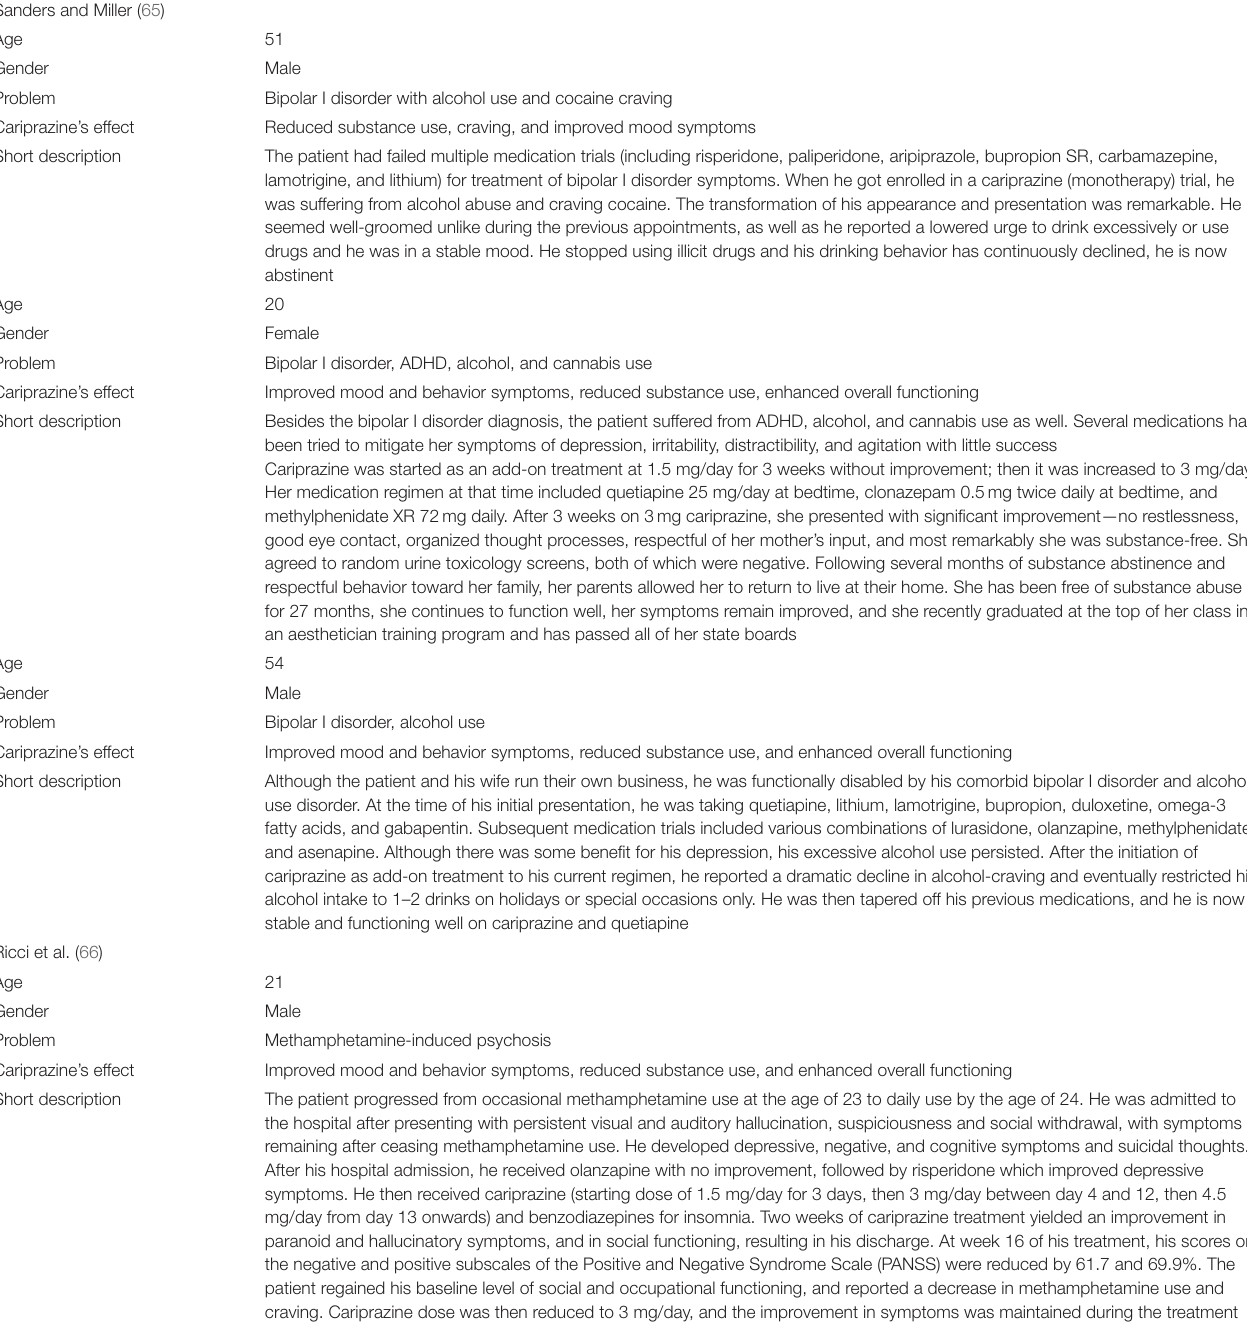
TABLE 1 | Cariprazine case